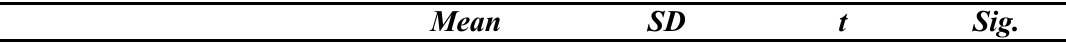
The Learning Perceptions for the